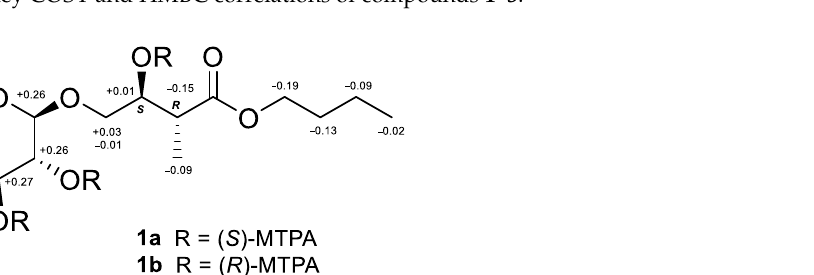
Figure 2. Key COSY and HMBC correlations of compounds 1 – 3 .